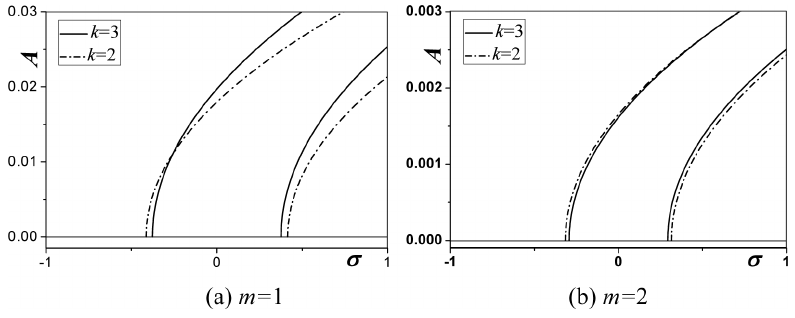
Fig. 6. Effects of the rotational spring stiffness: Eq. (14).